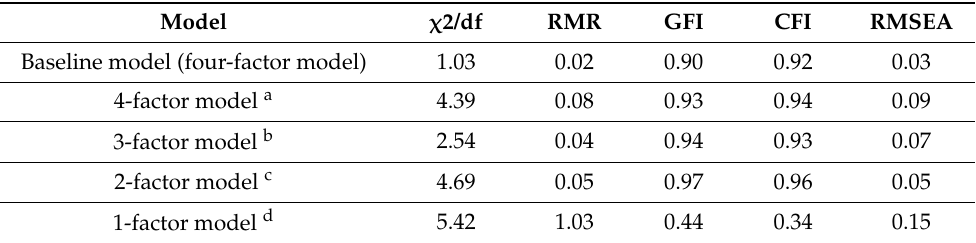
Table 2. Results of the confirmatory factor